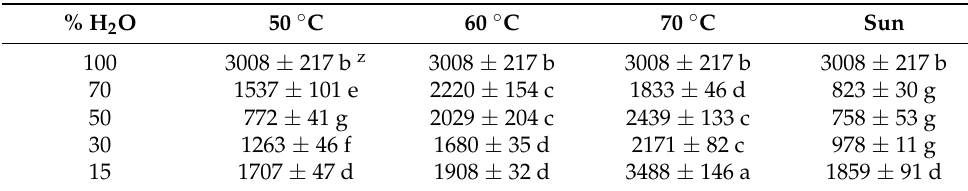
Table 3. Antioxidant activity (ORAC value expressed as µ mol TE/100 g DM) from the different drying